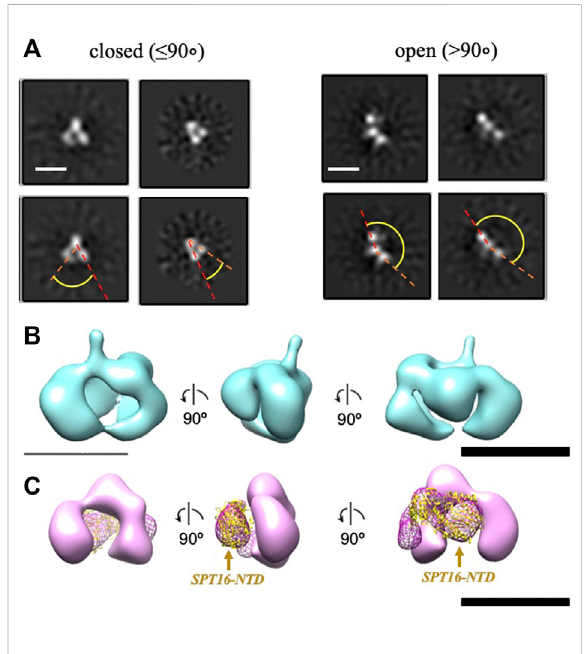
FIGURE 3 Three-dimensional reconstruction of FACT-SPT16 Δ NTD truncated mutant. (A) Representative 2D class-averages of the FACT- Δ NTD in the closed and open conformations. Scale bars — 10 nm. (B) 3D map of FACT in the compact conformation. (C) 3D map of the closed conformation of FACT- Δ NTD mutant (pink, the same orientations as in part (B) and the difference map with the intact FACT (magenta mesh). Atomic model of SPT16-NTD (yellow ribbon) was docked into the difference map with the correlation coef fi cient 0.92. Bar — 10